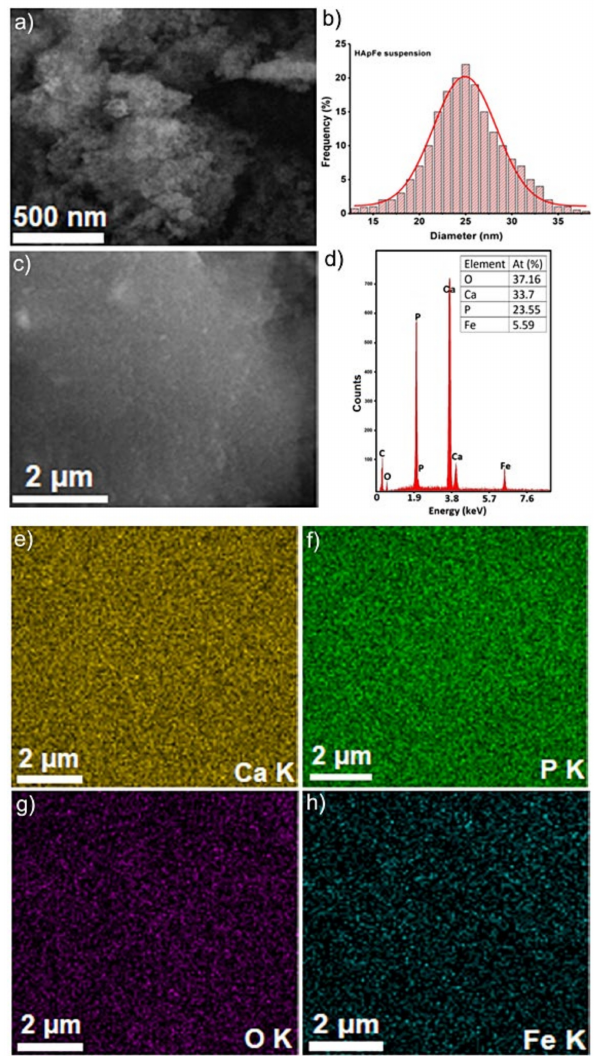
Figure 5. SEM micrographs of particle size distribution ( a , b ), SEM micrographs of elemental distribution